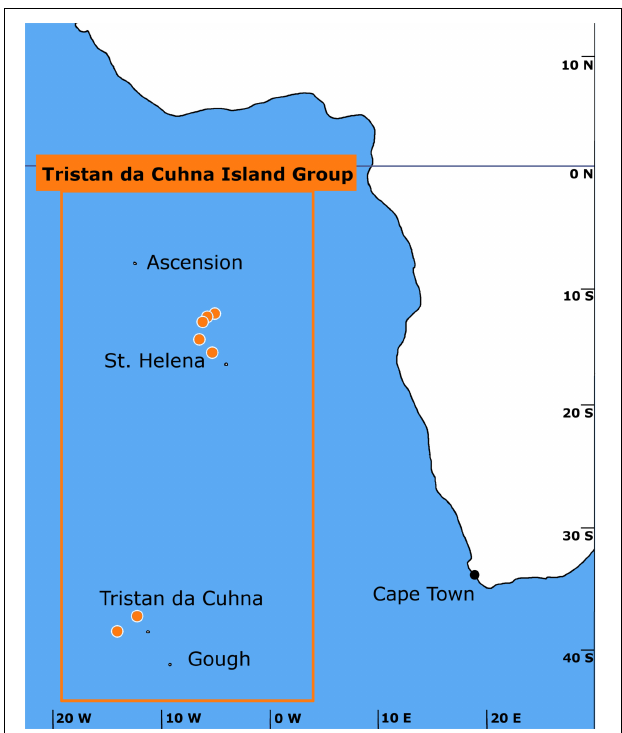
FIGURE 1 | Trawls (marked as orange dots with white borders) were conducted in the South Atlantic off St. Helena and Tristan da Cunha. A total of 44 trawls were implemented. One fish ( Gaidropsarus novaezealandiae ) was also collected from a rockpool on Tristan da Cunha and another ( Patagonotothen guntheri ) was caught in surface waters near the Falkland